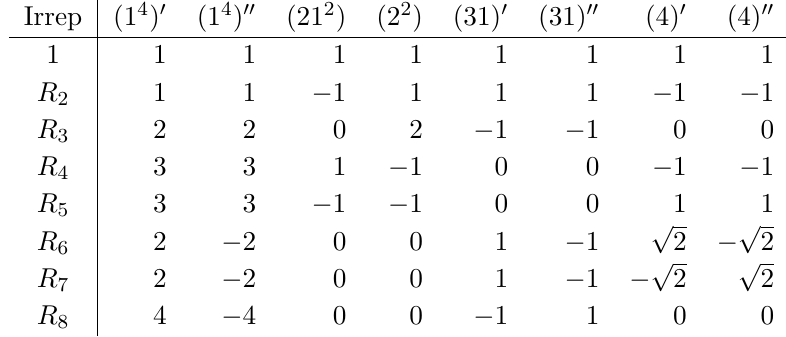
Table 4 . Character table for ˜ S 4 , from [53, table 4.7]. The notation for conjugacy classes references their images in S 4 , which are indicated with the same notation as in table 3. The primes refer to differences arising from including the central element z . For example, (1 4 ) 0 is the conjugacy class of the identity, whereas (1 4 ) 00 is the conjugacy class of z . See [53, theorem 3.8] for further